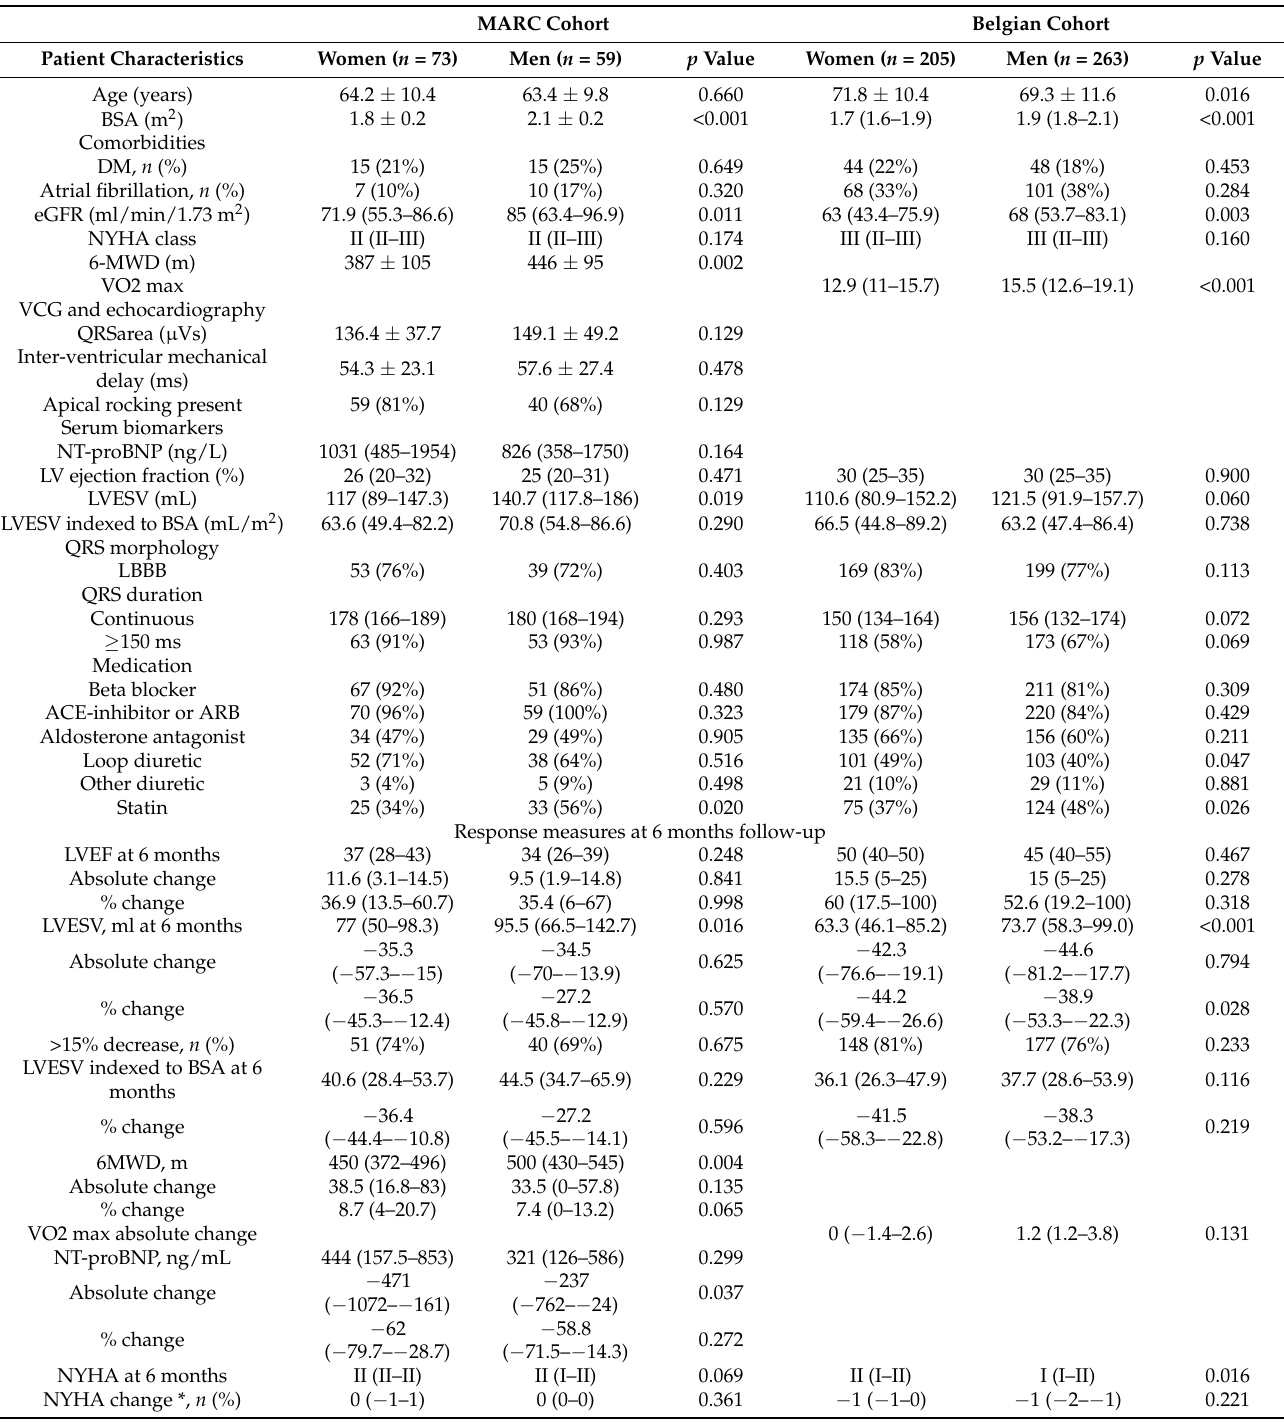
Table 2. Baseline table and response measures at 6 months follow-up of patients with non-ischemic etiology. MARC